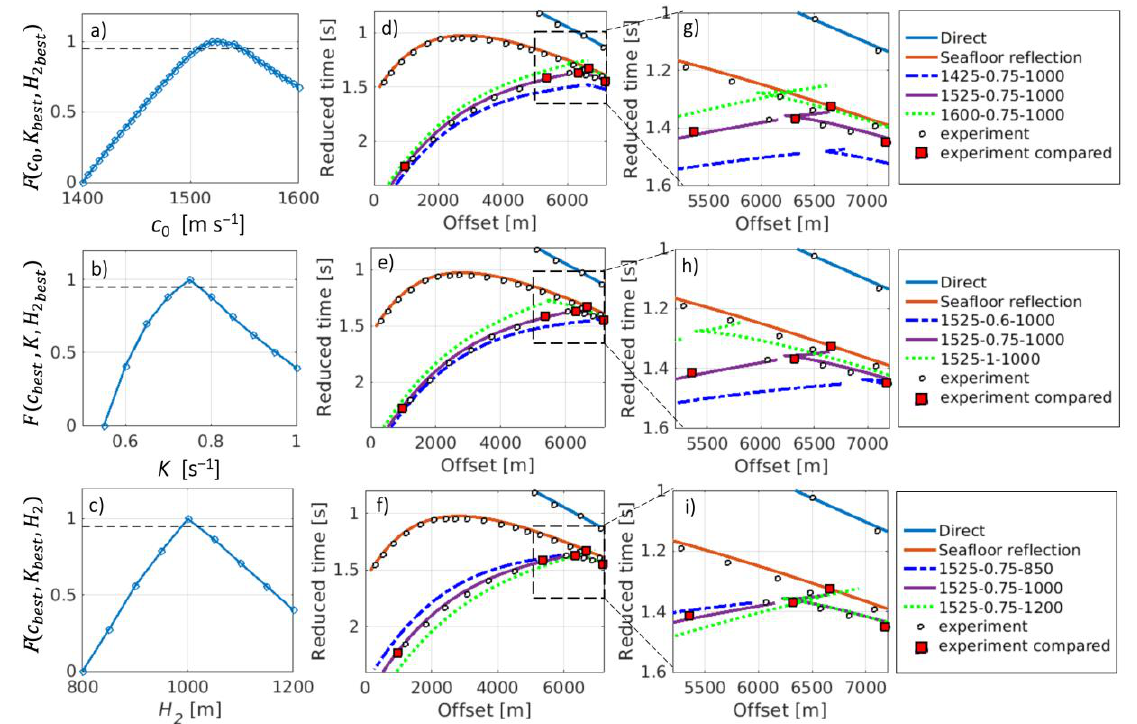
Figure 7. ( a ) The normalized weight function 𝐹 𝑛𝑜𝑟𝑚 vs. varying 𝑐 0 and 𝐾 with 𝐻 2𝑏𝑒𝑠𝑡 = 1000 m. The white area repre- sents arrival of the bending refracted rays beyond the bounds of the HLA used. The weight function has a single prominent maximum at 𝑐 0 = 1525 m s − 1 and 𝐾 = 0.75 s − 1 . ( b ) The arrival times simulated for three combinations of 𝑐 0 , 𝐾 , and 𝐻 2 (𝑏𝑜𝑡𝑡𝑜𝑚 𝑟𝑖𝑔ℎ𝑡) , overlaid with the experimentally chosen arrival times from source gather #2290. The reduction sound speed is 2000 m s − 1 . When 𝑐 0 and K are low (blue dashed line), the bending refraction is not observed within the offset range used. Normalized offset X n and normalized reduced time T n were used for calculations in Equation (5).